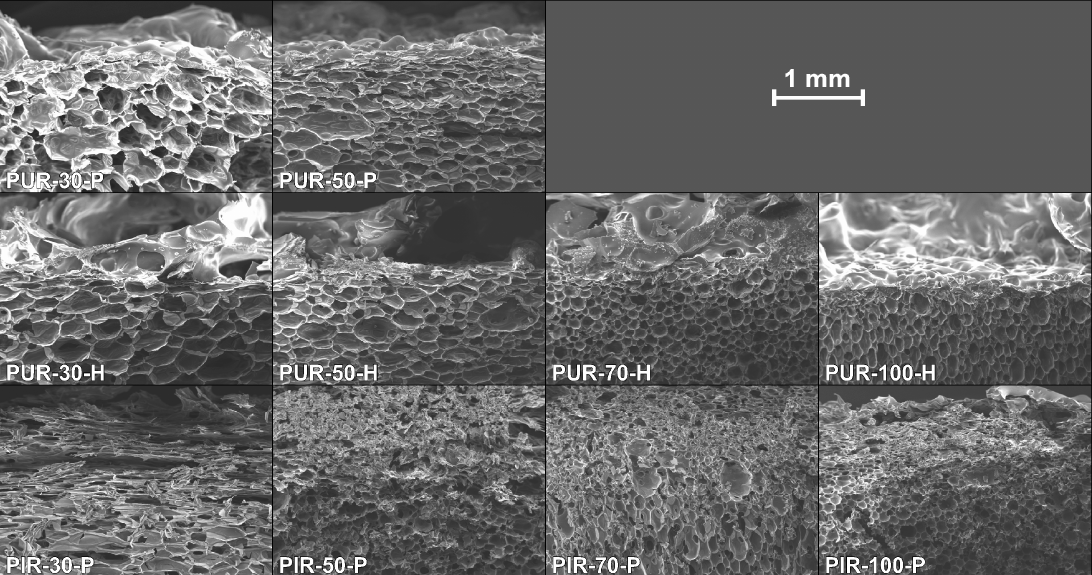
Figure 12. SEM micrographs of cross sections of quenched samples.